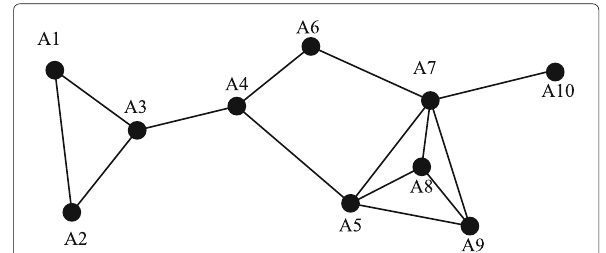
Fig. 2 A connected network of mobile